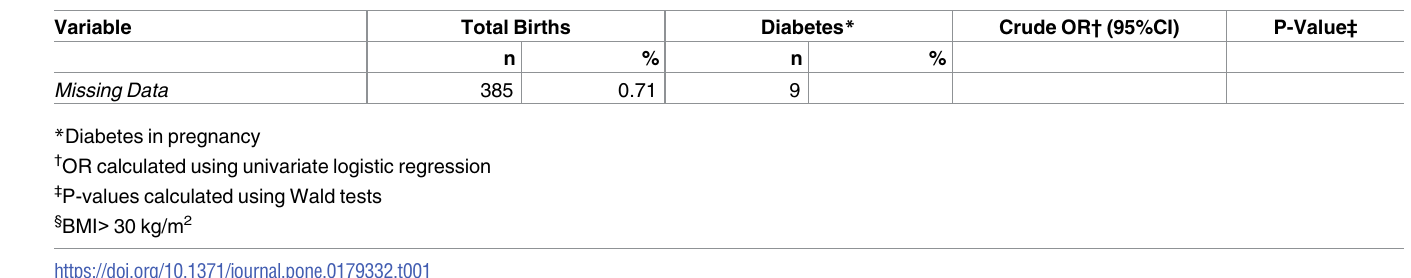
women (5.0% and 8.5%). The dashed line on Fig 2 represents the prevalence of diabetes in White women at BMI 30. The ‘risk equivalent’ (comparable to 30 kg/m 2 in White women) threshold for South Asian and East Asian women was approximately 21 kg/m 2 , and 27.5 kg/m 2 for Black women. Using BMI as a continuous predictor, the area under the ROC curve was 0.75 for South Asian women, 0.73 for Black women, 0.71 for White women, and 0.70 for East Asian women (Fig 3). These results suggest that BMI is an acceptable predictor of diabetes in pregnancy for all ethnic groups.